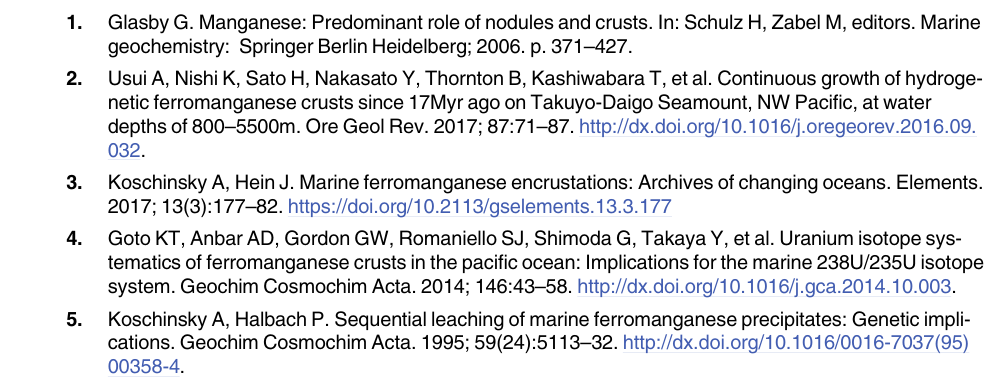
S6 Fig. Read-coverage-based rank abundant plot of contigs containing CDSs for catalases (KatE and KatG). Taxonomic affiliations for the genes are indicated on the bars. S1 Table. List of CDSs encoded in the MAGs. (PDF) S2 Table. List of accession numbers used in Fig 1.